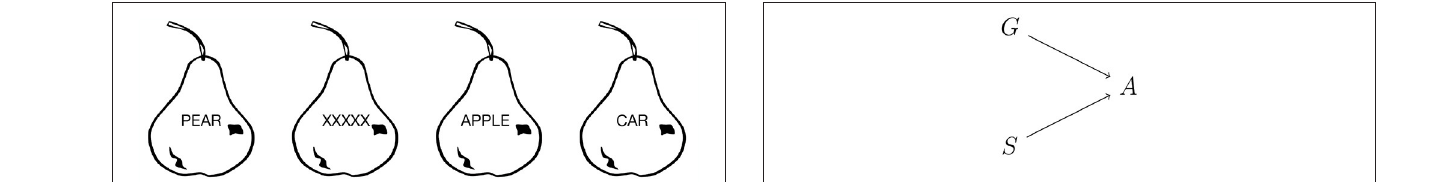
FIGURE 3 | Schematic of an action policy where the behavioral goal G and the perceptual state S jointly determine the output action A . bottom-up and top-down signals and must decide on an